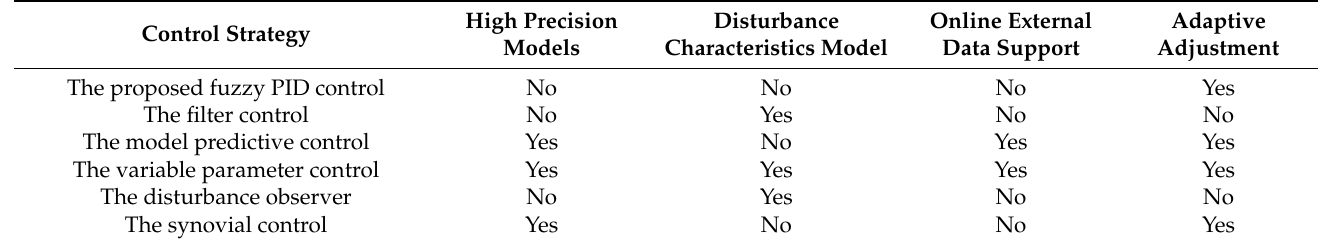
Table 4. Comparison of frequency regulation control strategies.